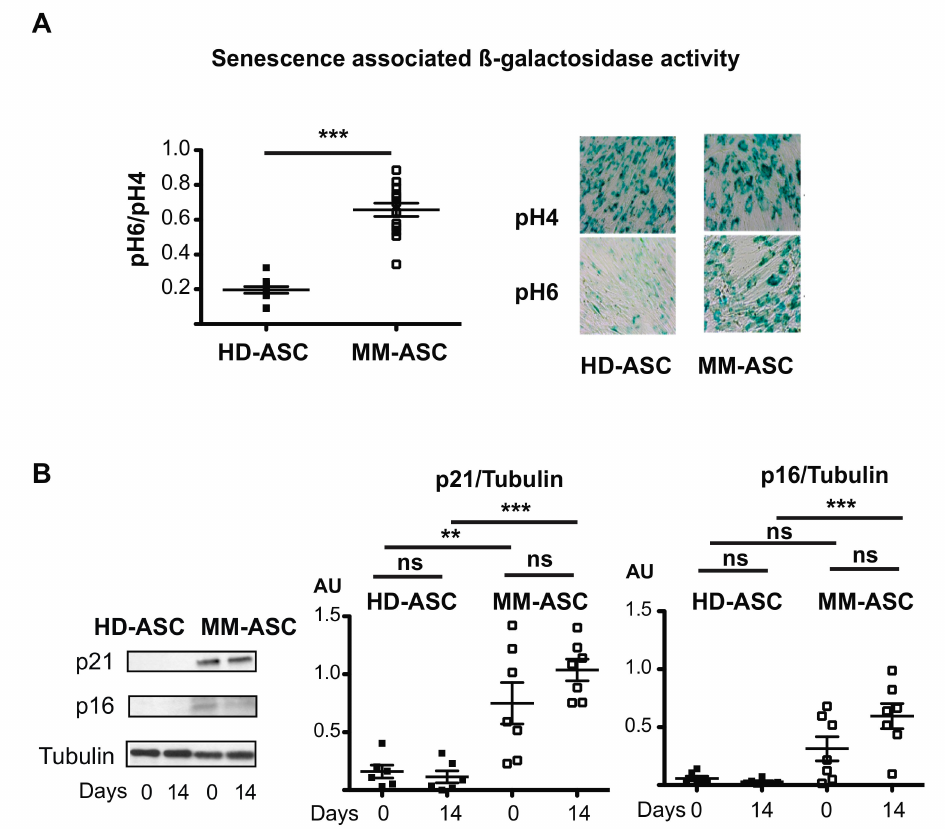
Figure 4. Senescence in MM-ASC versus HD-ASC. ( A ) SA β -galactosidase activity was assessed according to the ratio of pH 6- to pH 4-positive staining after 14 days of differentiation (left). Representative micrographs of β -galactosidase positive cells are shown (right). ( B ) Whole cell lysates were extracted from ASC on day 0 or 14 of differentiation and analyzed by immunoblotting. Representative immunoblots of the cell cycle arrest markers p21, p16, tubulin (loading control) are shown in the left panel and Western blot quantifications in the two right panels. * p < 0.05, ** p < 0.01, *** p < 0.001. AU: Arbitrary units.